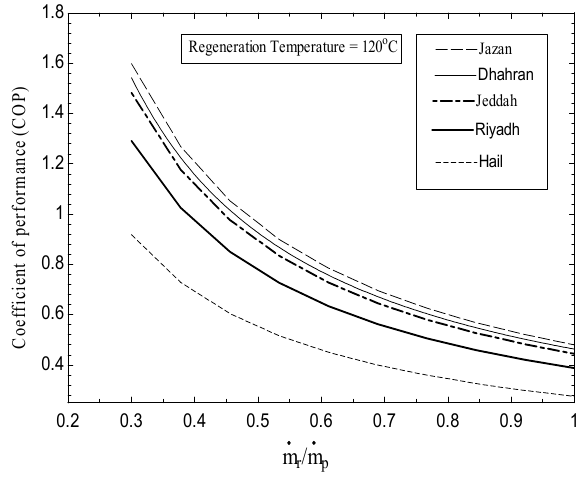
Figure 8. Variation of coefficient of performance with ratio of mass flow rates.